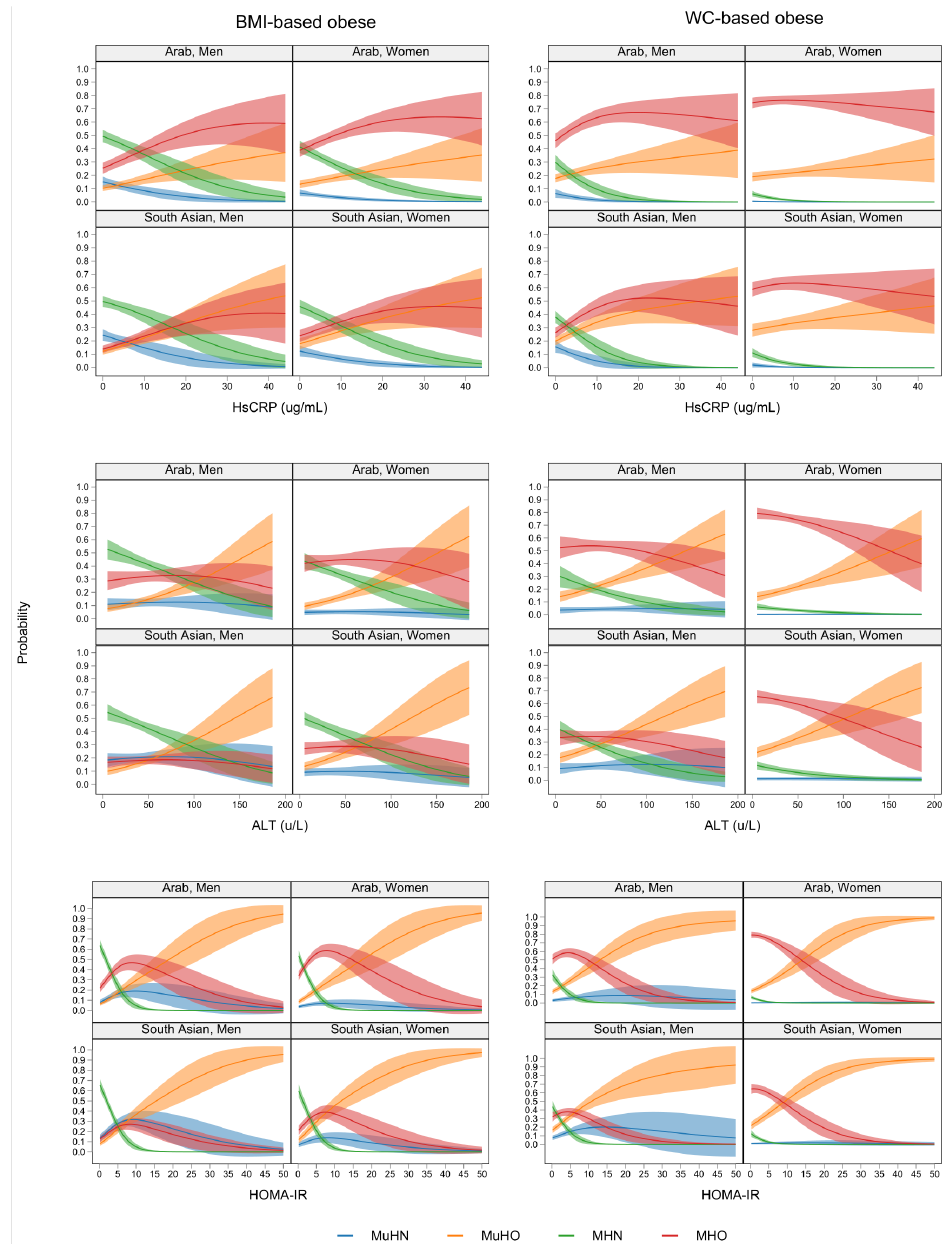
Figure 3. Non-linear relationship between hs-CRP, ALT, and HOMA-IR, and the metabolically healthy and unhealthy obese phenotypes by ethnic group and